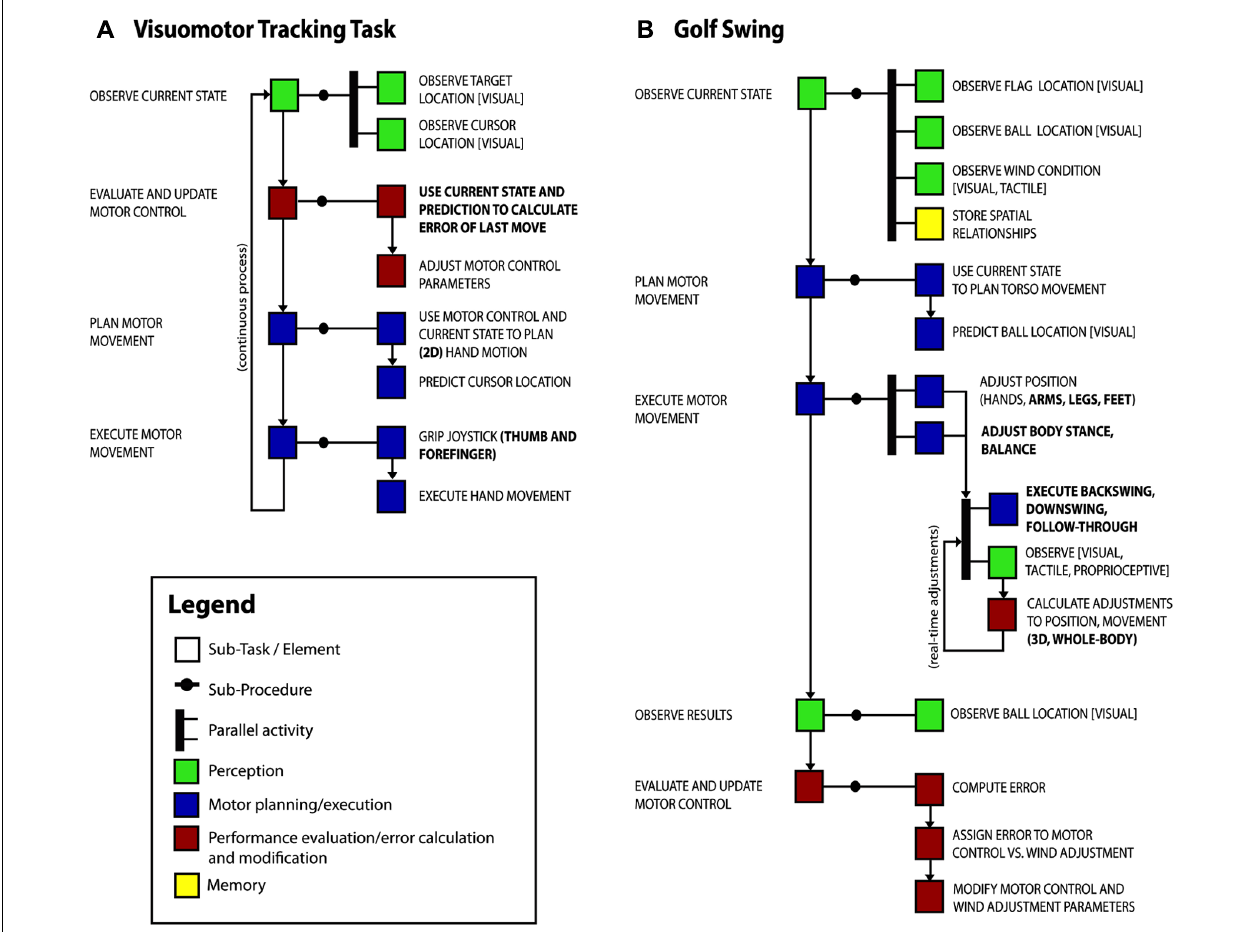
(perception – green, motor – blue, evaluation/error calculation – red, memory – yellow), though the elements themselves are likely to be more useful for task comparison. Arrows show dependencies between sub-tasks and thick bars indicate concurrent activities. Components that differ between the visuomotor tracking task and the golf swing are in bold